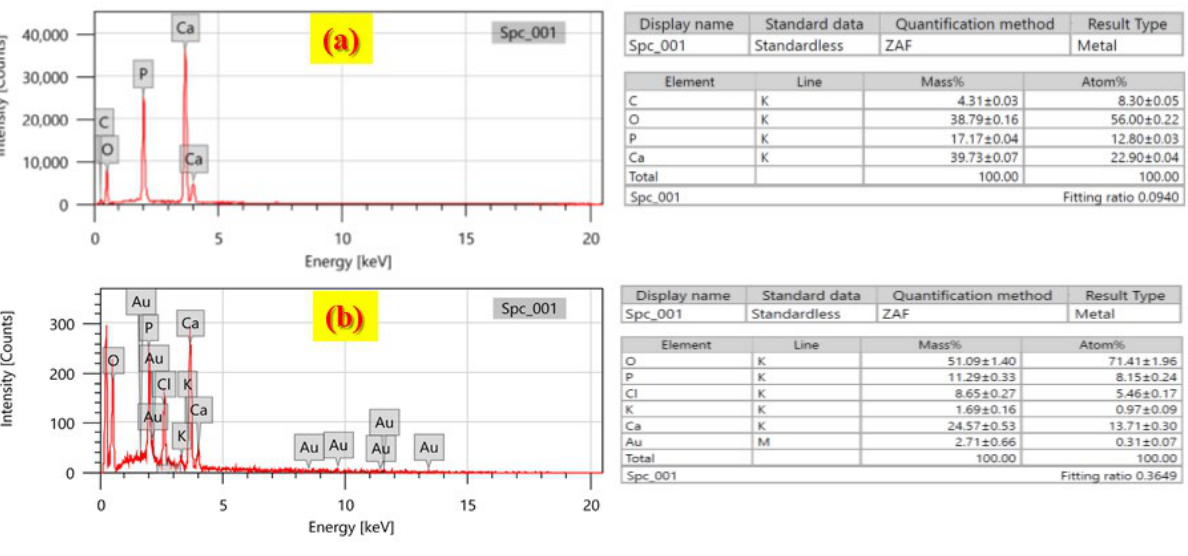
Figure 5. EDS spectra of ( a ) Hydroxyapatite and ( b ) HA/Au nanocomposite.